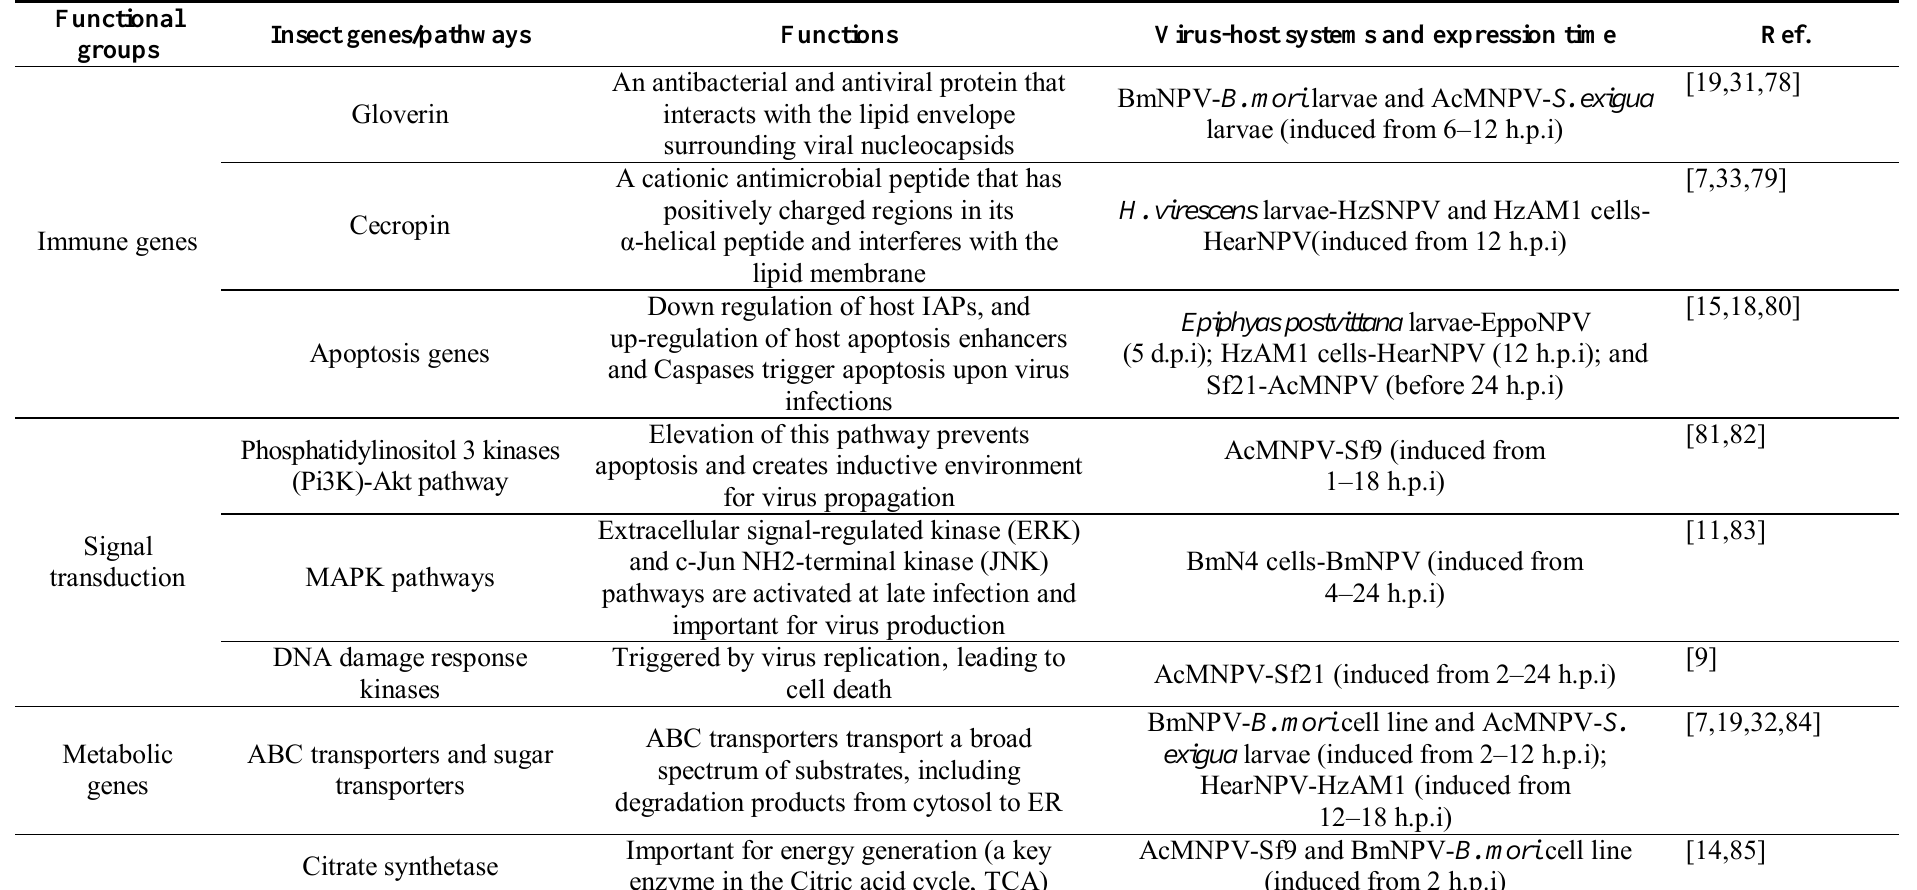
Table 2. Host genes that respond to/are affected by baculovirus infections *